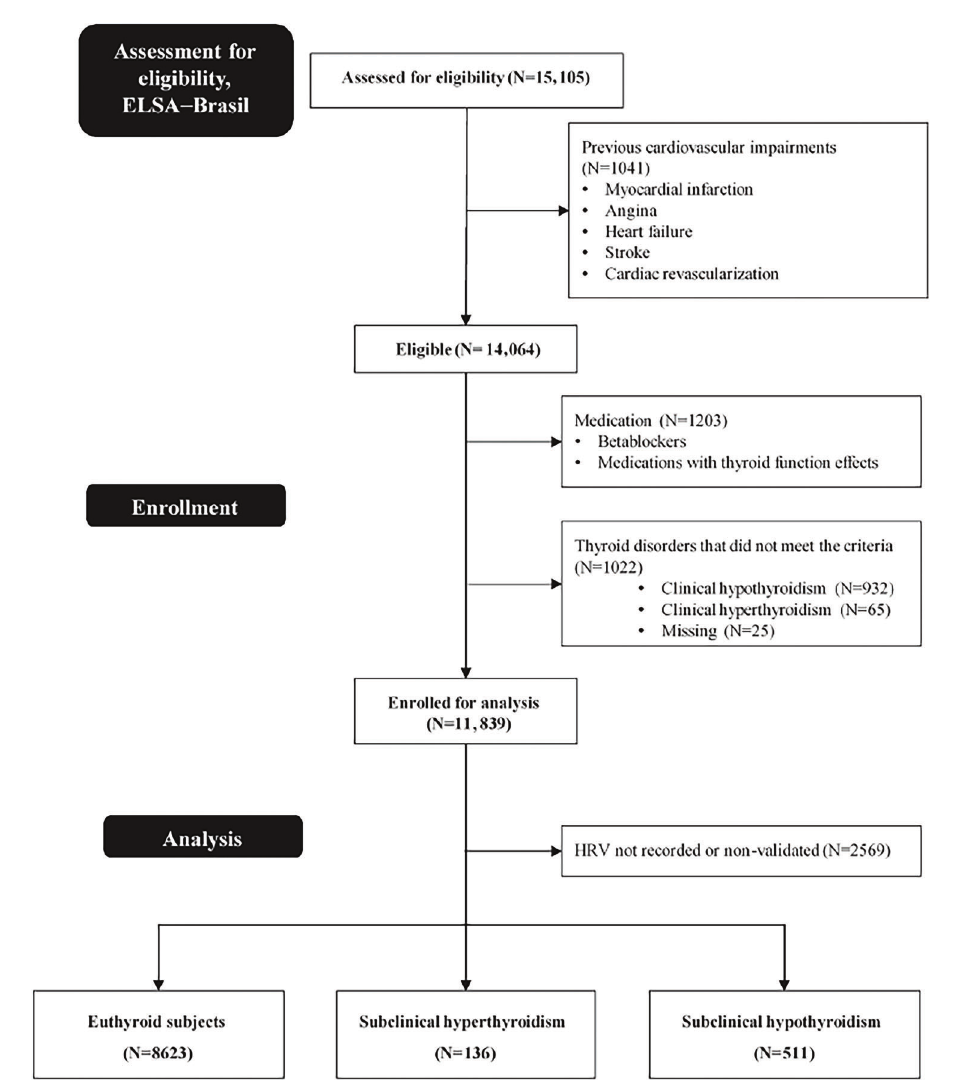
Figure 1. Flow-chart of the study. HRV: heart rate